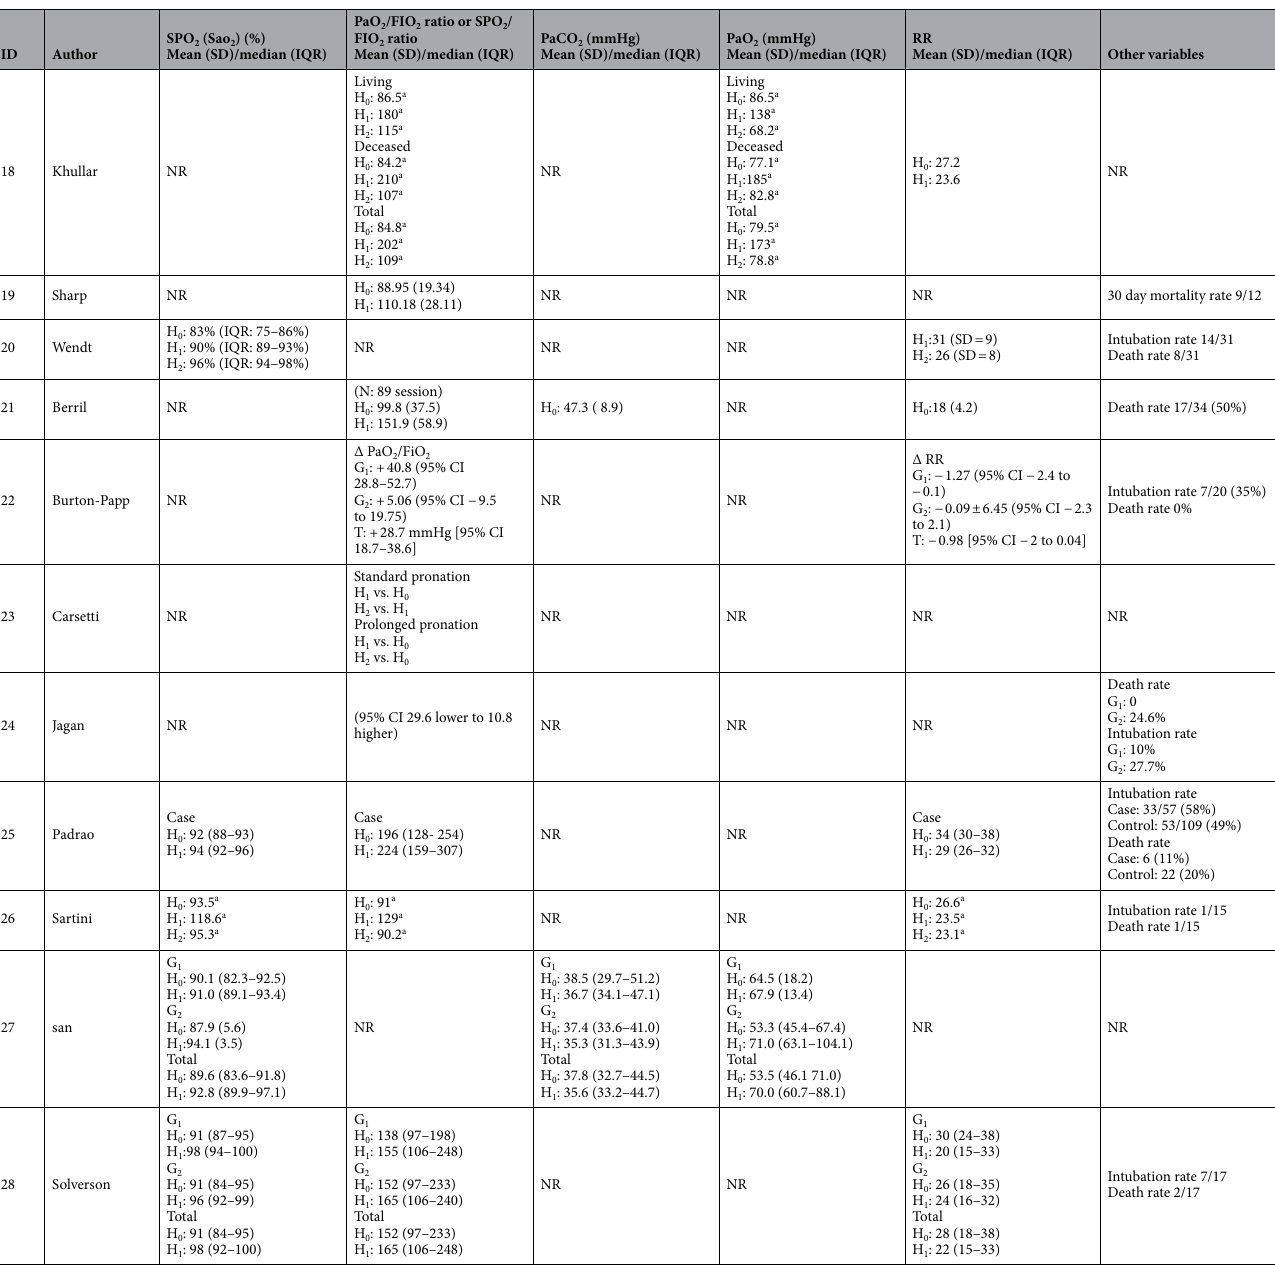
Table 2. Respiratory parameters, intubation rate, and death rate in COVID-19 patients. H hour, Spo 2 pulse oximeter oxygen saturation, Sao subdistibution hazard ratio, SS sample size, NR not reported. a Data extracted from figures and